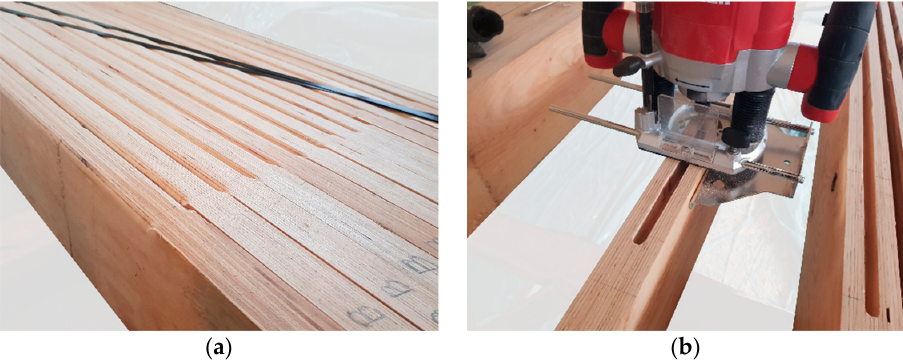
Figure 4. View of prepared LVL beams: ( a ) with rounded corners; ( b ) with groove.